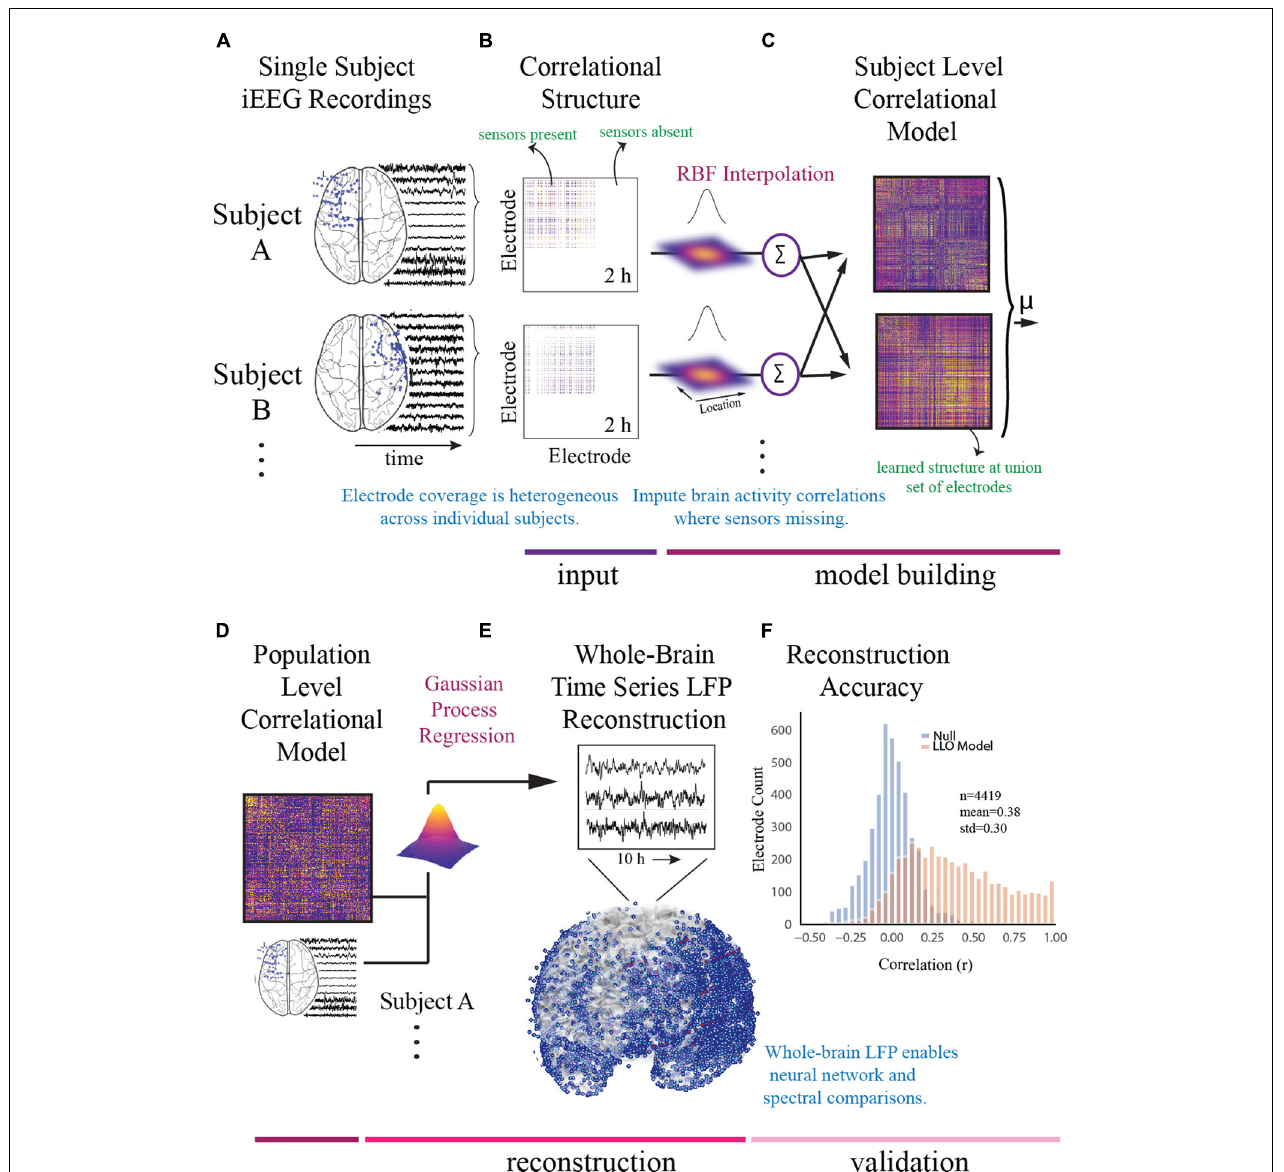
FIGURE 2 | Construction of whole-brain model. (A) To generate a multi-subject whole-brain model of iEEG activity, patient’s electrode locations across participants were first represented in a common space [Montreal Neurologic Institute (MNI) space]. Electrode locations and sample recordings for a few example patients are shown. Activity was then randomly sampled in 1 min intervals across daytime hours to obtain a stable representation of brain activity across a 2-h period. (B) Individual inter-electrode correlation matrices were constructed for each participant at locations where electrodes were present. (C) Subject-level full brain correlational models were then predicted using radial basis function (RBF)-weighted averages to estimate brain activity correlations at locations where sensors were not present. (D) Subject-level correlational models were then averaged to generate a population level whole-brain correlational model. (E) Local field potential activity for each of the 4,244 electrodes was then reconstructed using Gaussian process regression with the population-level model as a prior and activity where electrodes were present as the marginal likelihood. (F) The distribution of the electrode signal reconstruction accuracy across true correlational models (orange) compared to reconstruction accuracy obtained from shuffled correlational models. To obtain this distribution we built models with 53/54 patients, and then applied the model to the held-out patient, holding out each patient in turn. Correlation of the true and reconstructed signals were compared for each held-out electrode. Significance was assessed by averaging the patient level Fisher transformed correlation coefficients and comparing the distribution for the true correlational model and the shuffled correlational model using a t -test ( t = 13.94, p = 1.04e − 25